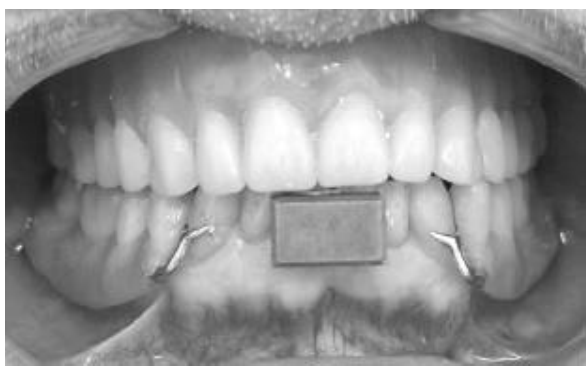
FIGURE 2 - Magnet affixed in the patient’s labial